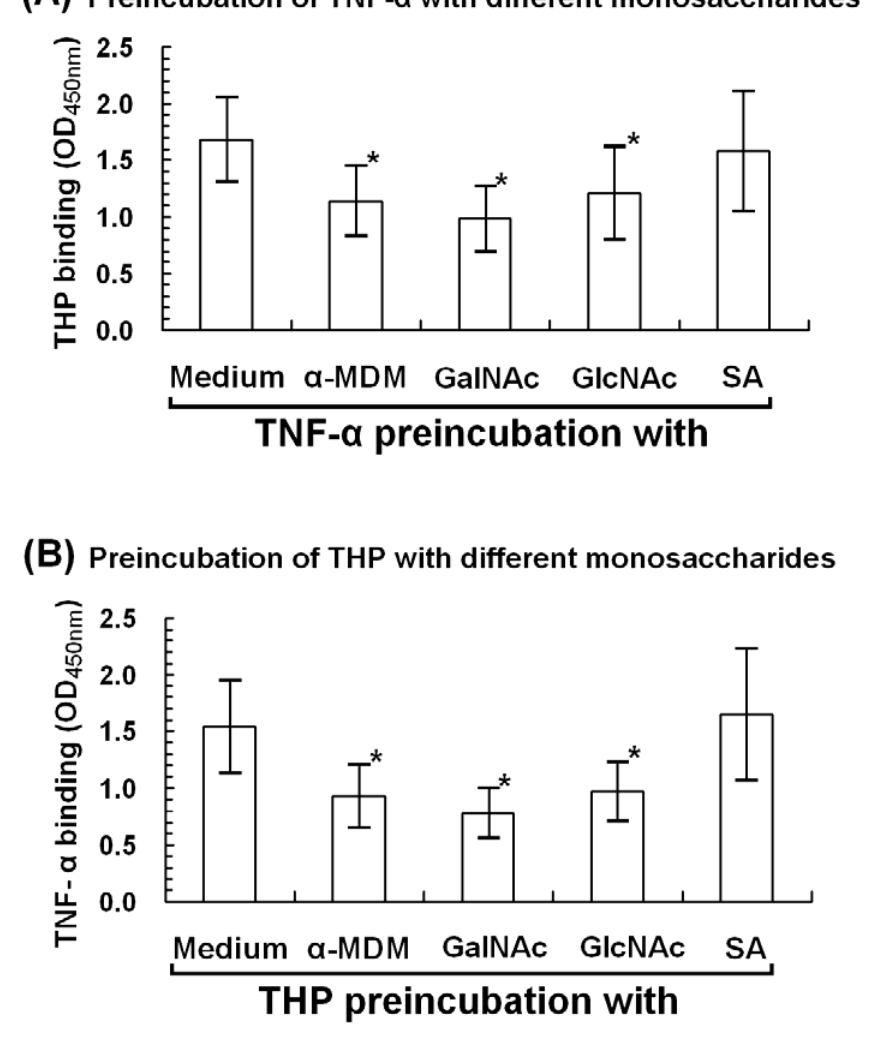
Figure 6. Monosaccharide inhibition assay was conducted to identify the carbohydrate(s) mediating THP and TNF- α binding. ( A ) TNF- α -precoated microcells were incubated with α -methyl- D -mannoside ( α -MDM), N-acetyl-galactosamine (GalNAc), N -acetyl- glucosamine (GlcNAc), or sialic acid (SA) for 2 h, incubated with THP, and detected by ELISA ( B ) THP-precoated microwells were incubated with monosaccharides for 2 h, incubated with TNF- α , and detected by ELISA. * denotes p <